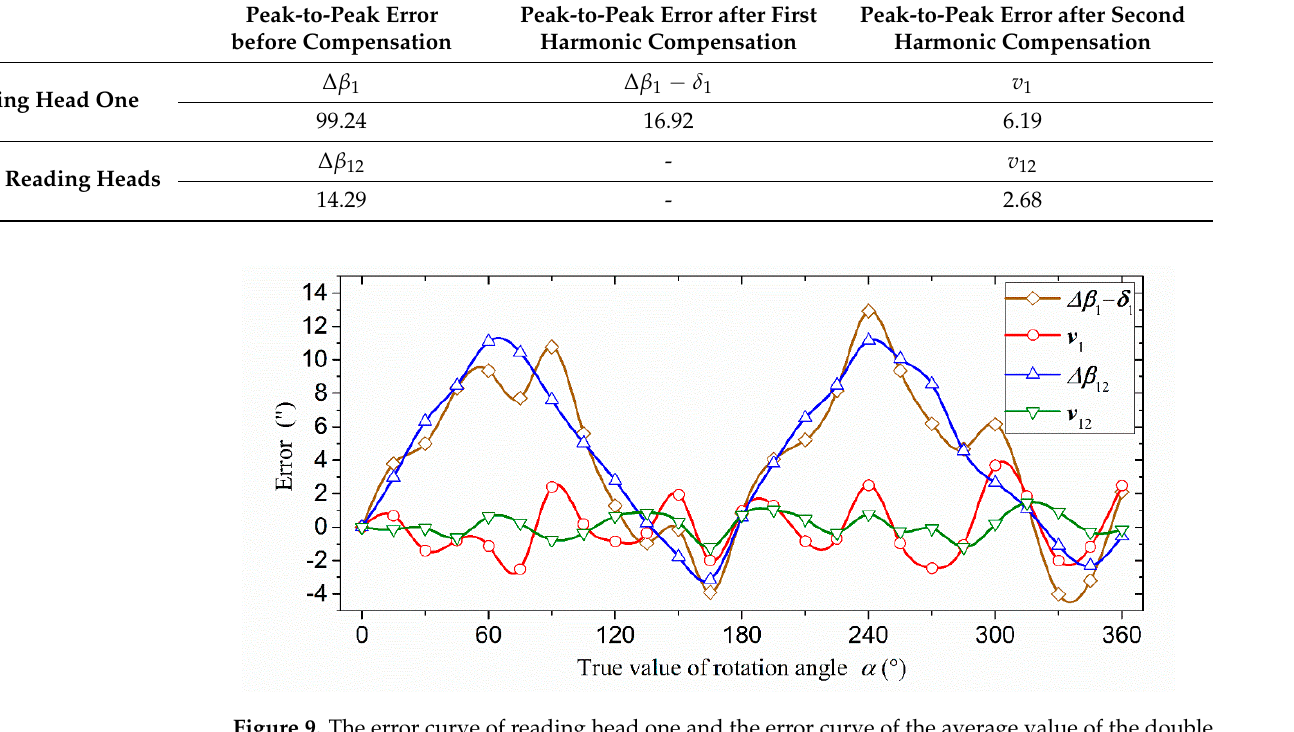
Figure 9. The error curve of reading head one and the error curve of the average value of the double reading heads.